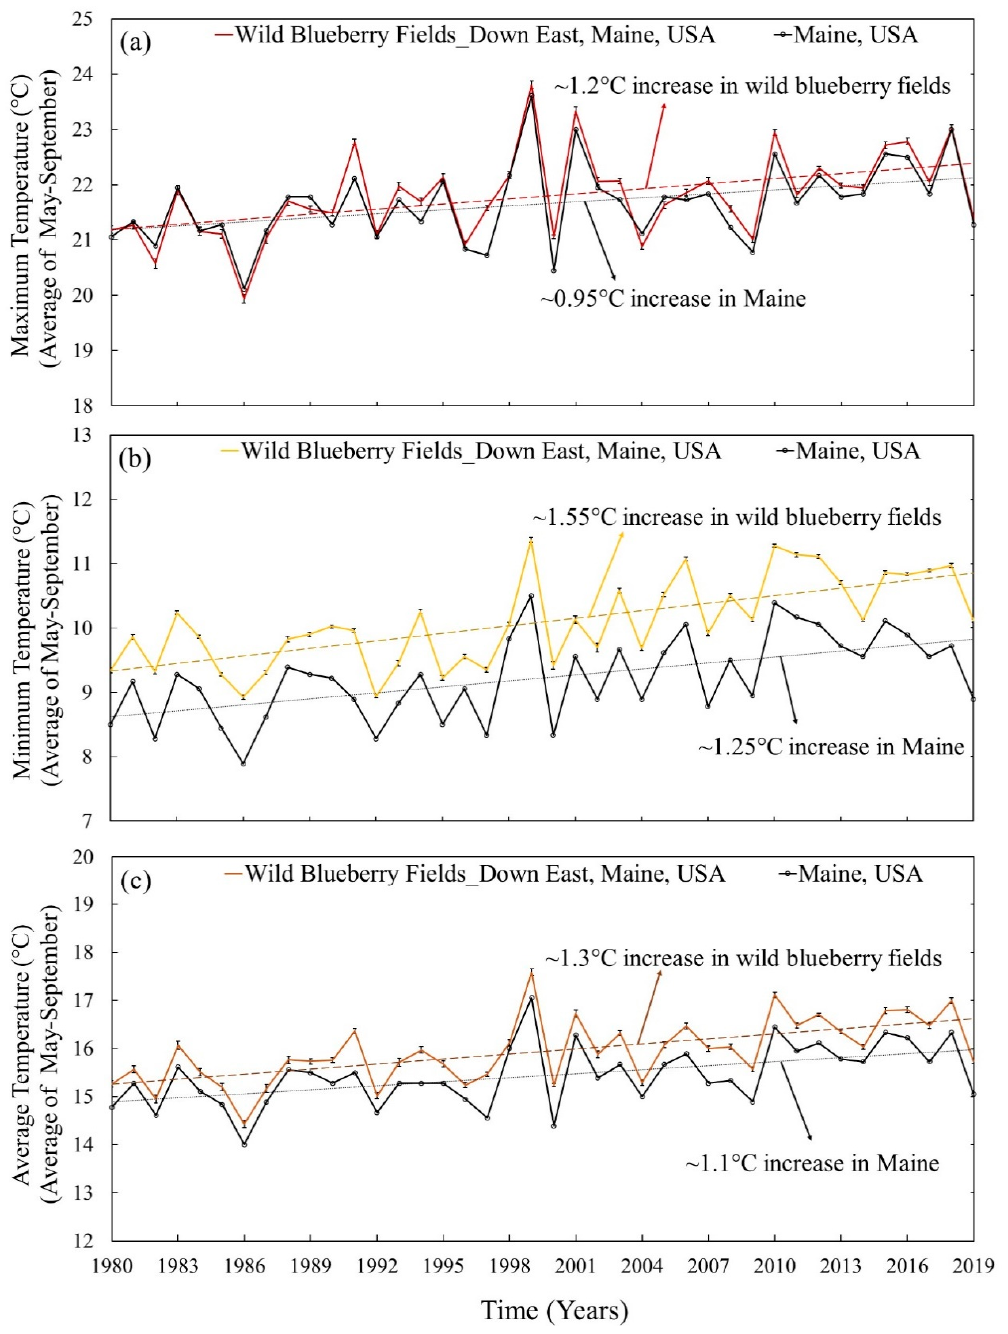
Figure 2. Historical (1980 to 2019) changes in ( a ) maximum temperature (average of May–September), ( b ) minimum temperature (average of May–September), and ( c ) average temperature (average of May–September) throughout the state of Maine (averaged spatially), as well as at the 26 wild blueberry fields (shown in Figure 1) in Downeast, Maine. The climate variables from the fields are represented as the mean ± standard error (n = 26). The dotted lines are linear regression lines for the state of Maine and the dashed lines are linear regression lines for the wild blueberry fields in Downeast Maine over 40 years from 1980 to 2019.